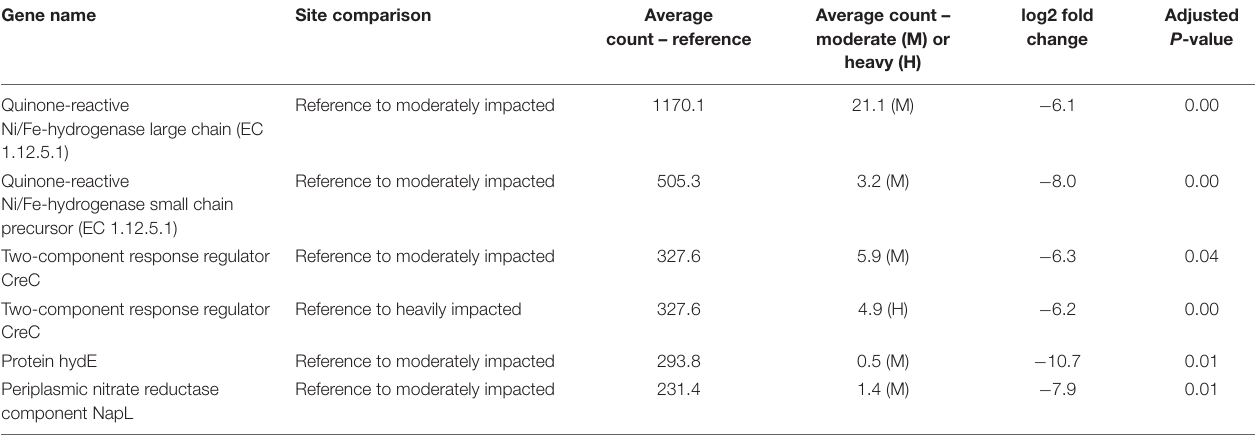
TABLE 3 | Statistically significant ( P < 0.05) differentially abundant genes (DAGs) analyzed in